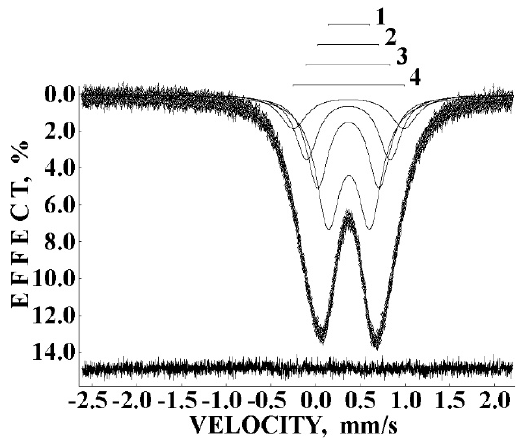
Figure 3. Two schematical views on the ferritin structure with indications of protein multi ‐ subunit shell and the iron core.